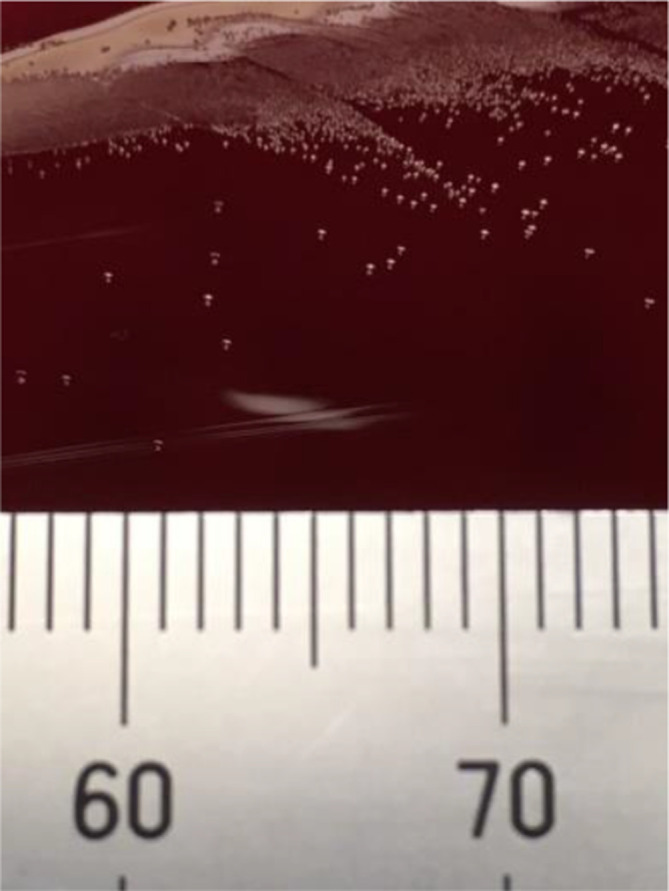


F. sanguinis
 on Brucella blood agar.